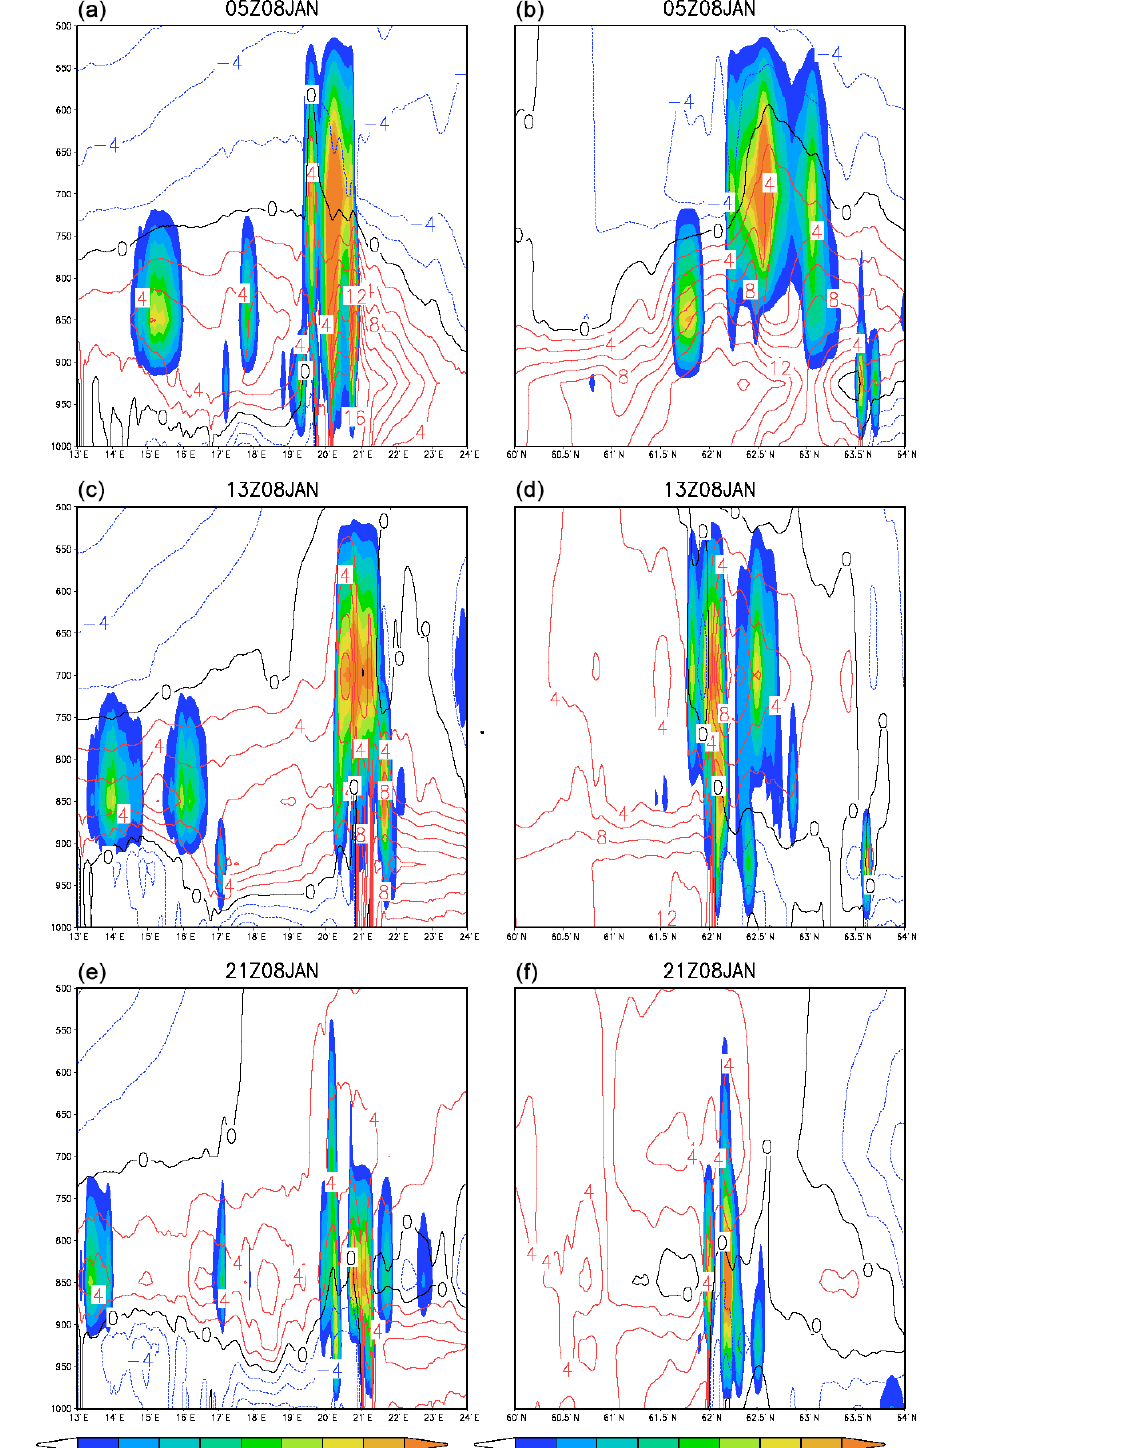
Figure 6. Vertical cross section from 1000 to 500hPa of cloud water and ice (gm − 2 ) and meridional wind speed (ms − 1 , southerly in red, northerly in blue) along 62 ◦ N (a, c, e) and along 21 ◦ E (b, d, f) , as simulated by HARMONIE for 08:00UTC (a, b) , 13:00UTC (c, d) , and 21:00UTC (e, f) on 8 January 2016. For the latitude and the longitudes, see segment lines in Fig.